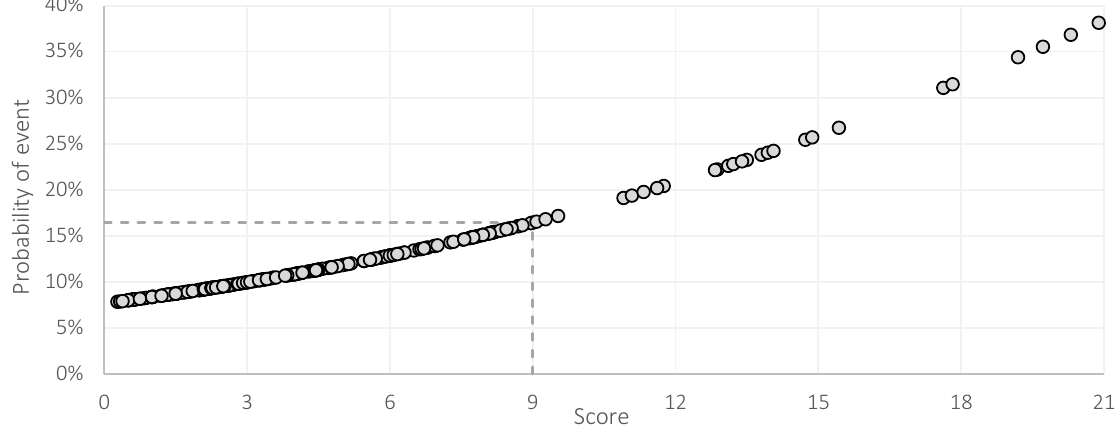
Figure 4. Logit curve regression for the probability of loss in